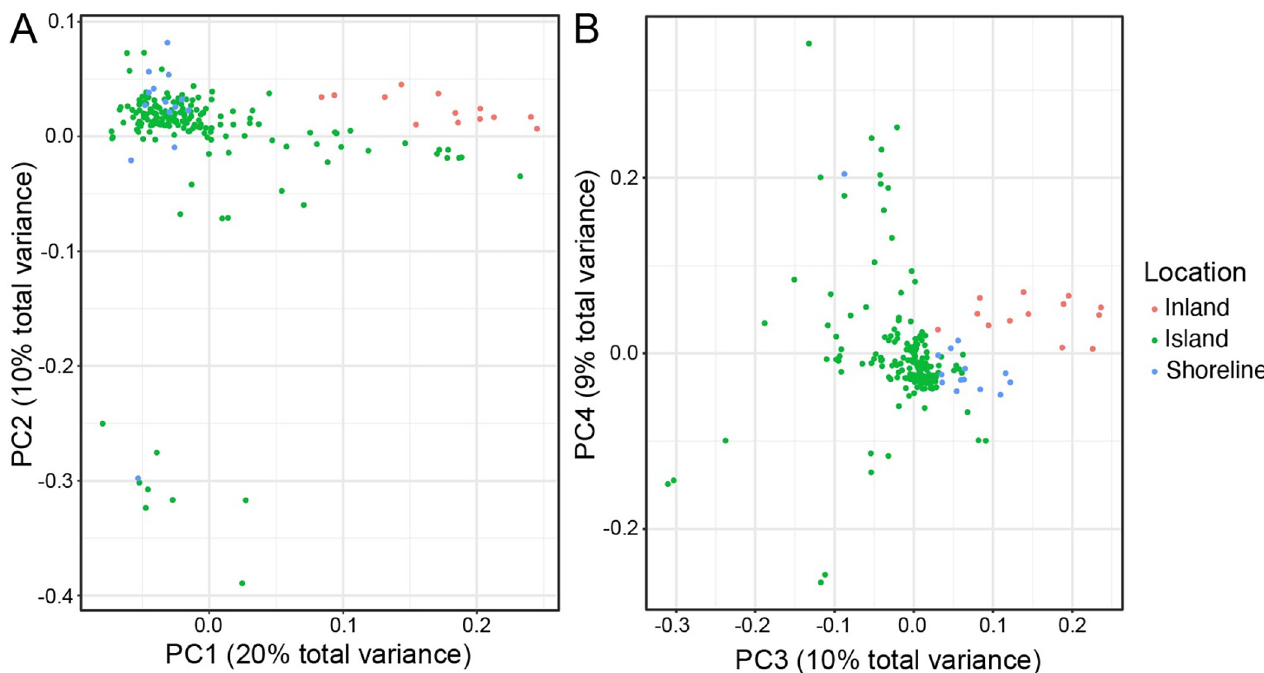
Fig 2. Principal components analysis of genetic variation within study samples and comparator Ugandan populations. (A) Shows the first two principal components and (B) the third and fourth principal components. Each point represents a single miracidium, coloured by the population from which they are sampled, with ’Shoreline’ samples from Mayuge district and ’Inland’ from Tororo